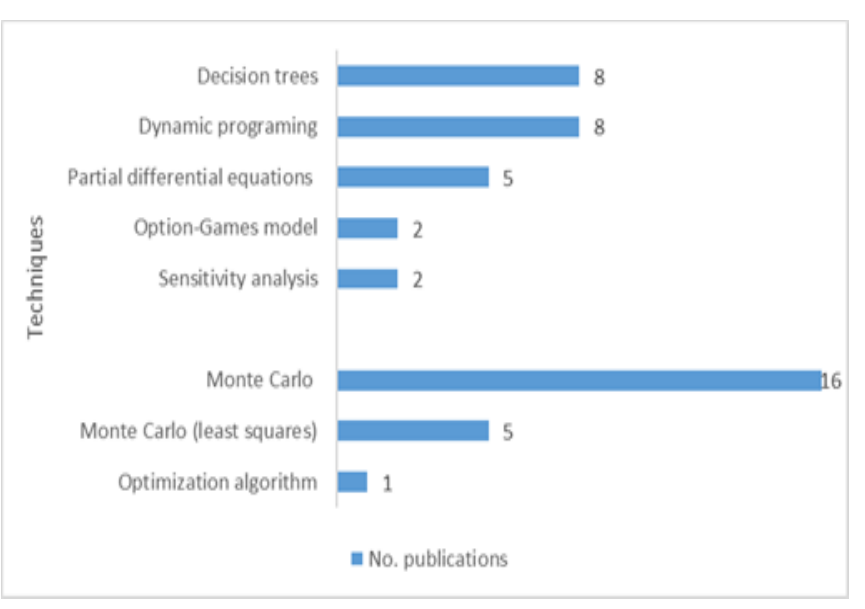
Figure 12. Real options valuation techniques.